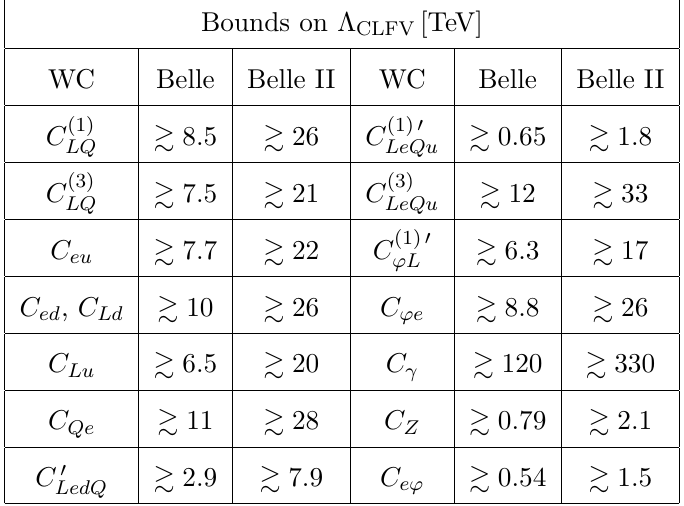
Table 2 . Bounds on the new-physics energy scale mediating CLFV phenomena ( Λ CLFV ) in tau decays. Here, we consider C ≈ 1 . The results are based on Belle and Belle II limits, given at the 99.8 % confidence